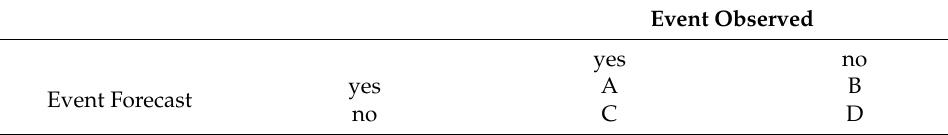
Figure 7. The gray circle contains the 91 rain gauges (colored points) that registered the heaviest rainfall in the 6 h ending at 0300 UTC on 10 September. The sample black circle contains the (i.e., roto-translated) 91 transformed rain gauges obtained by varying the parameters d and φ . For each forecast, the verification procedure extracted the predicted precipitation values (samples shown with the red contours) at the black points’ locations and calculated the root mean squared error against values reported at the colored points. Table 3. The 2 × 2 contingency